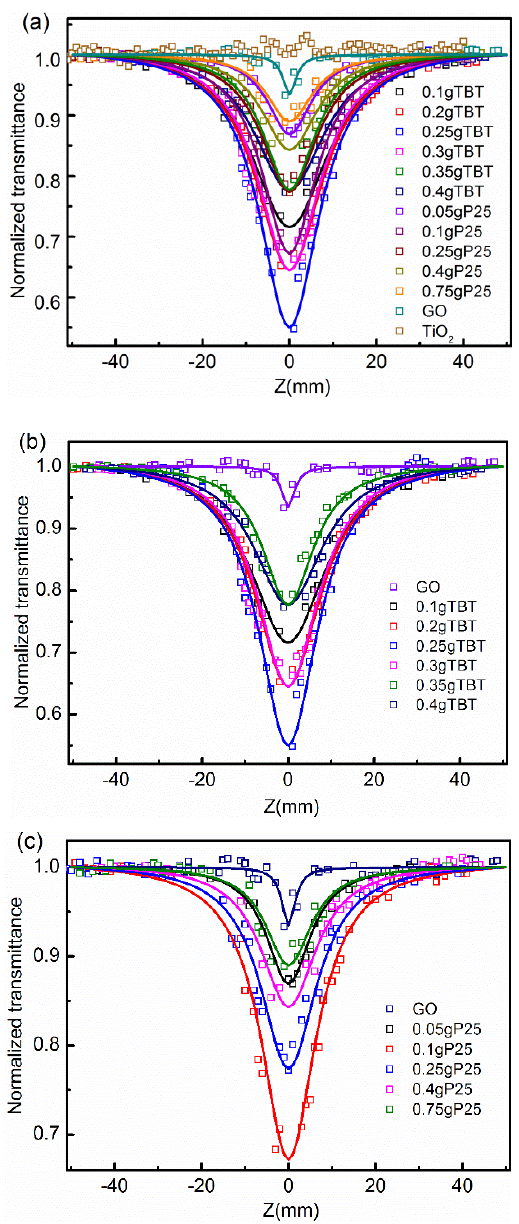
Figure 7. Open aperture Z-scan normalized transmittance curves using 6 ns laser pulses at 1064 nm for GO, TiO 2 , TBT samples, and P25 samples ( a ), GO and TBT series samples ( b ), GO and P25 series samples ( c ).